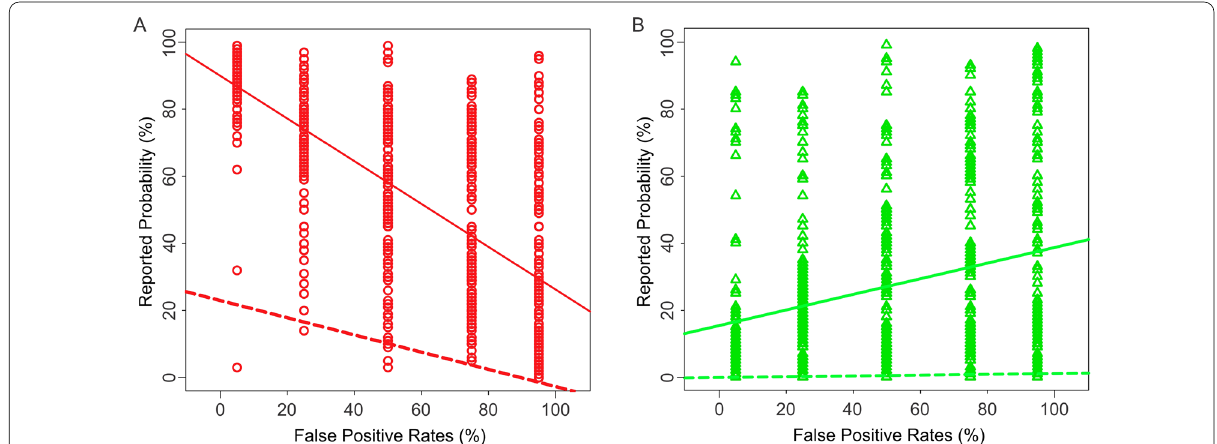
Fig. 4 The interaction between the false alarm rate and the binary decision of the system in Experiment 2, as revealed by one-way ANCOVA (binary decision x false alarm rate). The data are plotted in this figure using the same conventions as in Fig. 2. The numeric results of the ANCOVA are shown in Additional file 1: Table